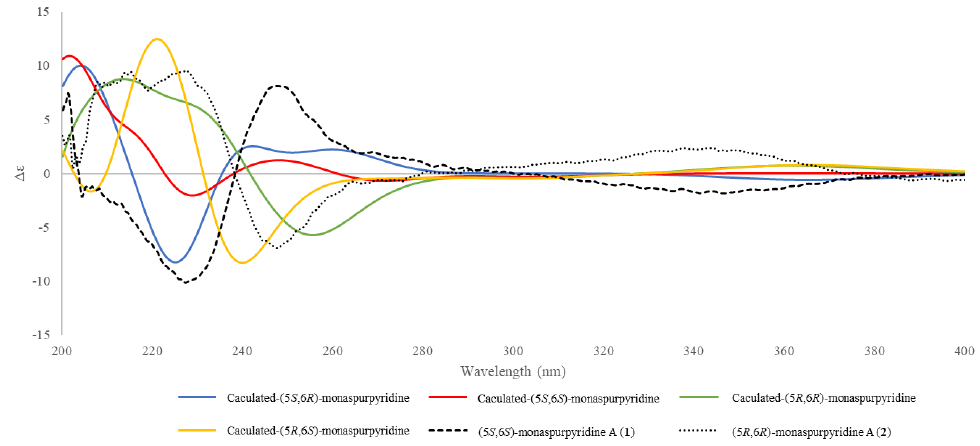
Figure 3. Comparison of the experimental (dash) and calculated (color) ECD spectra of 1 and 2 . Compound 3 was obtained as a yellowish solid, and the molecular formula was assigned as C 21 H 22 O 7 based on the HRESIMS, indicating 11 indices of hydrogen deficiency (IHD). The 1 H NMR spectrum of 3 indicated the existence of three methyl groups, including one singlet at δ H 1.52 (s, H-12), one triplet at δ H 0.94 (t, J = 7.2 Hz, H-17), and the acetyl methyl proton at δ H 2.59 (s, H-11) (Table 1). It also showed three methylene groups ( δ H 1.67 (sextet, J = 7.2 Hz, H-16), 2.57 (t, J = 7.5 Hz, H-15), 3.62 (d, J = 16.5 Hz, H-13b), and 3.79 (d, J = 16.5 Hz, H-13a)), one ortho -coupling aromatic protons ( δ H 6.65 (d, J = 9.0 Hz, H-1)/7.73